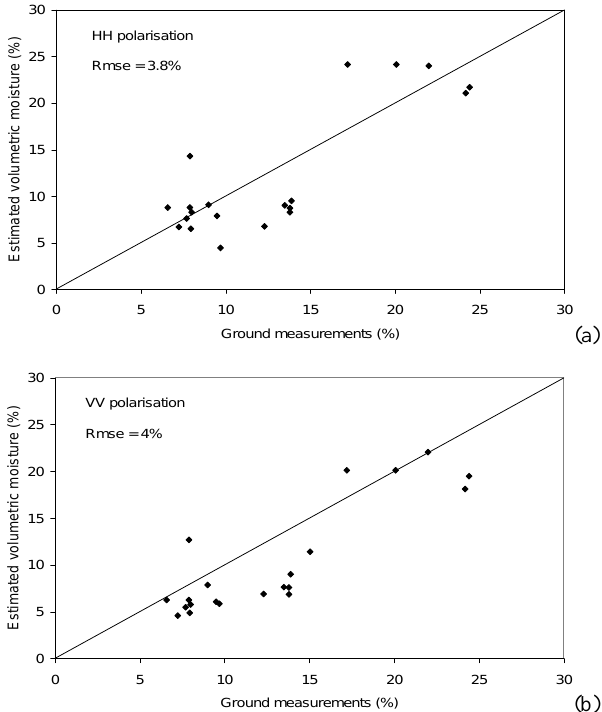
Fig. 5. Soil moisture estimations from ENVISAT ASAR data, ex- pressed as a function of the soil moisture derived from ground-truth measurements, for fields in the “olive tree” class of land use, (a) HH polarisation, (b) VV polarisation.